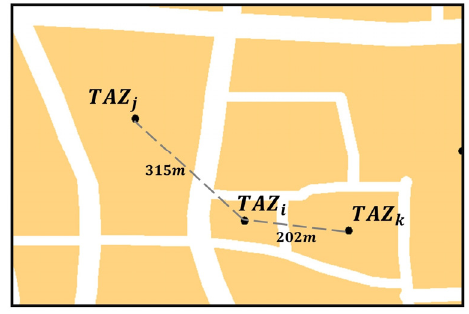
Figure 11. Proximity expression of TAZs.